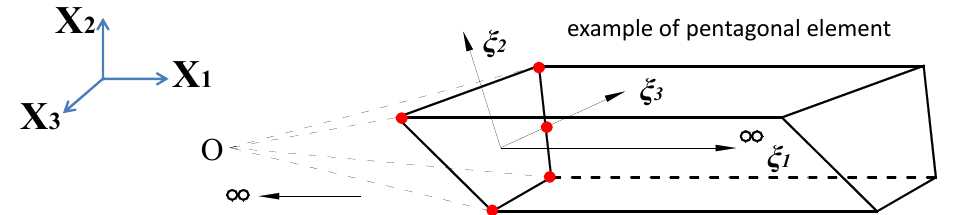
Figure 2. Typical polygonal scale boundary finite element of fluid.